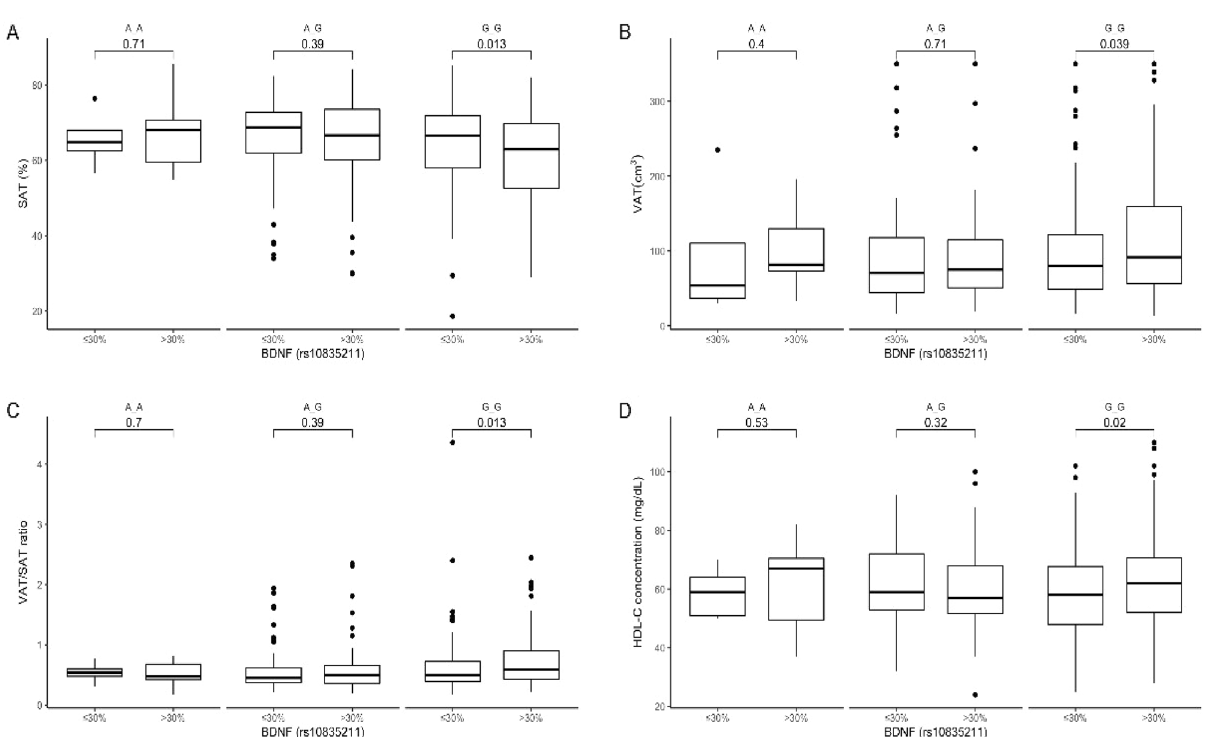
Figure 4. The ( A ) SAT (cm3); ( B ) VAT (cm3); and ( C ) VAT/SAT ratio ( D ); HDL-C concentration (mg/dL) in BDNF rs10835211 genotypes carriers stratified by daily fat intake (≤ 30% and > 30% of total daily energy